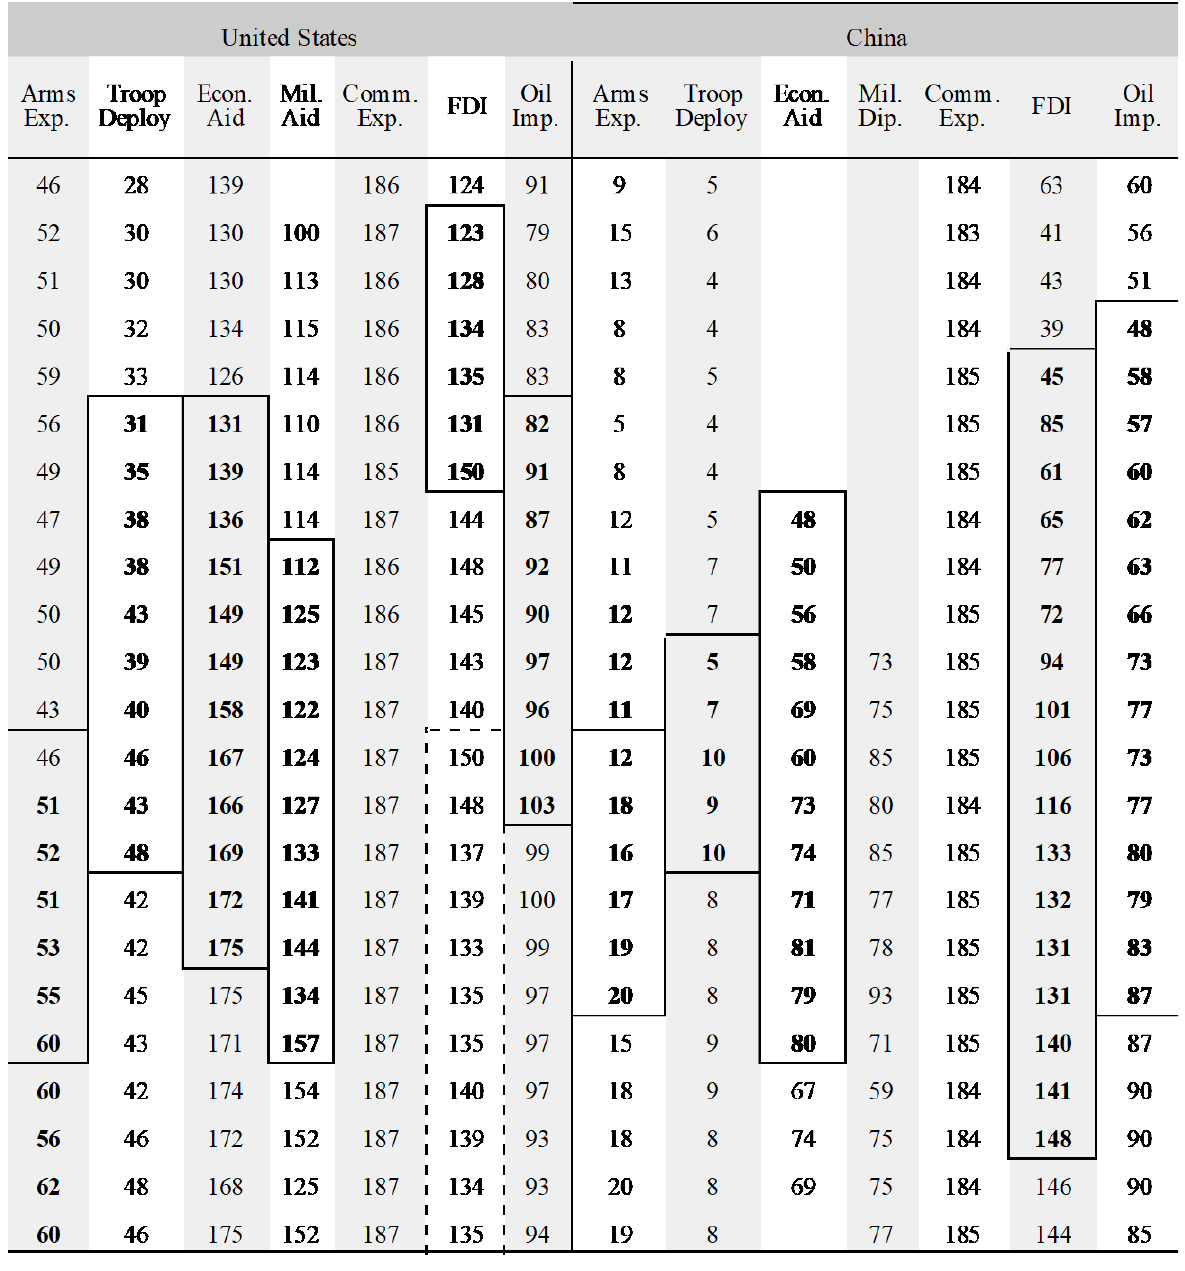
Table 1: Total Size of Economic and Political-Military Networks, 1993-2015 ("key years" of significant change in network size